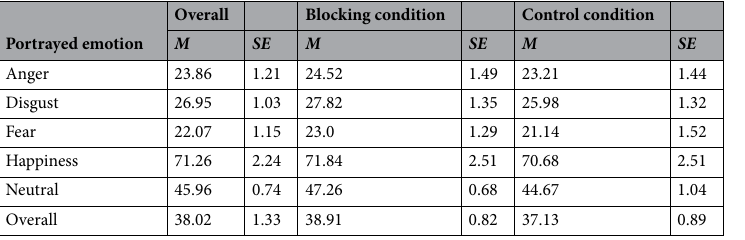
Table 2. Valence ratings. Mean values and standard errors for five emotion categories divided into two blocking conditions. Valence was measured on a scale from 1 to 100, with 1 being the most negative and 100 being the most positive.